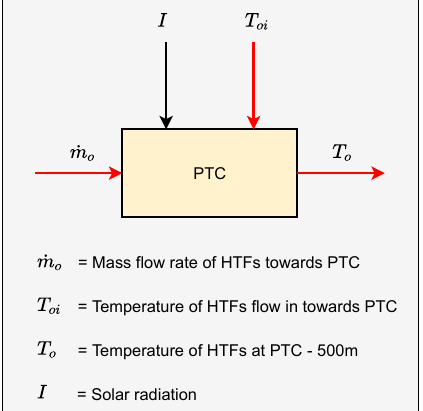
Figure 3. PTC schematic (open-loop